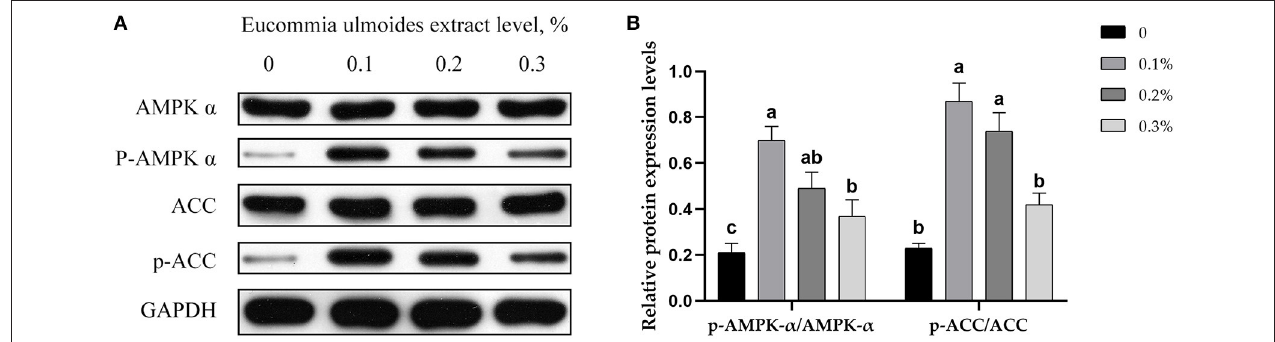
FIGURE 3 | (A) Representative immunoblots of protein levels and phosphorylation degrees of AMPK- α , p-AMPK- α , ACC, and p-ACC, in backfat tissue of growing–finishing pigs. (B) Relative protein expression levels of p-AMPK- α /AMPK- α and p-ACC/ACC. Data are expressed as means ± SEM. a − c Values with different letters are significantly different among dietary ELE treatments ( p ≤ 0.05) ( n =